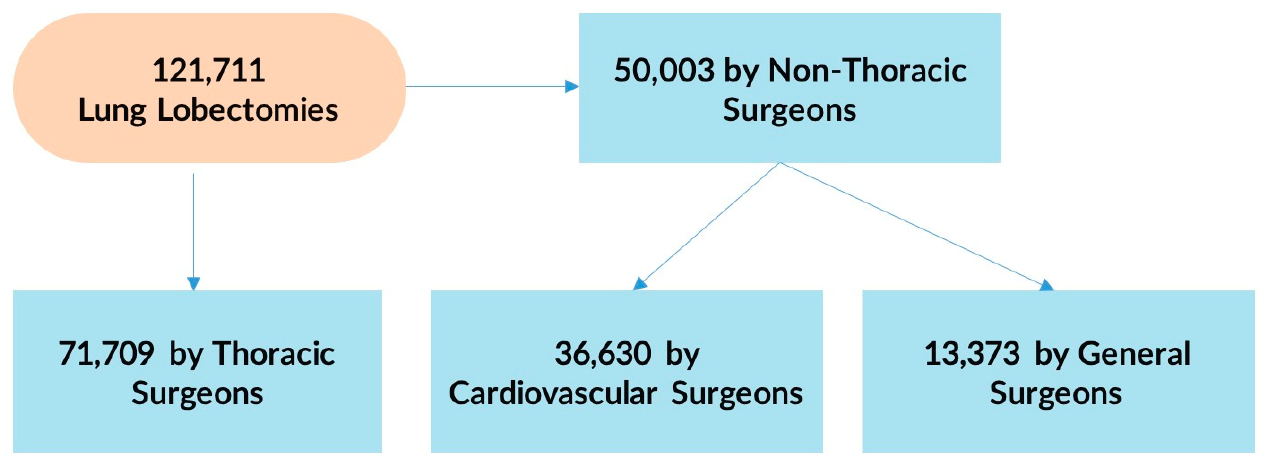
Figure 1. Overall percentage of lung lobectomies performed by each provider type in the Premier Healthcare Database from 2009 to 2019.